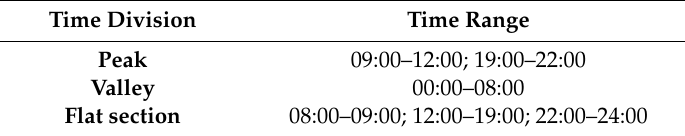
Table 3. Step price list in a certain area of